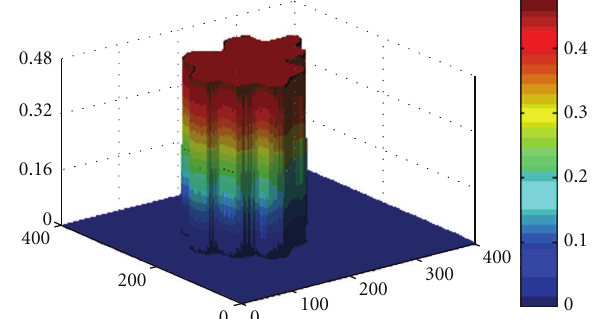
Figure 1: Test 1. Image size: 840 × 840, simulated image and its contour to compute.